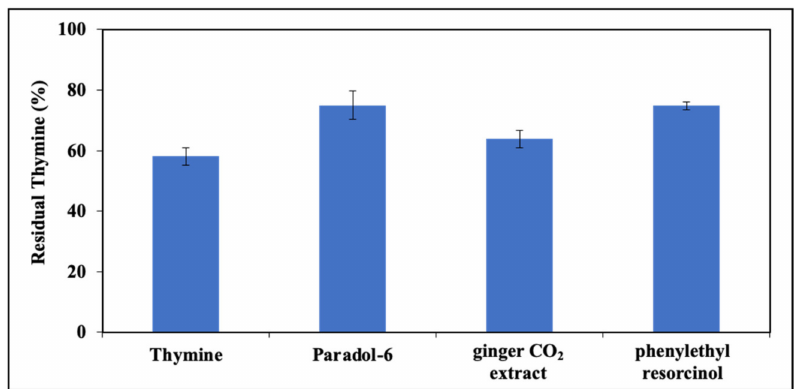
Figure 10. Residual thymine in DNA expressed as percent compared to control after UV exposure (3 h). Data are expressed as mean ± SD of three independent experiments, each performed in